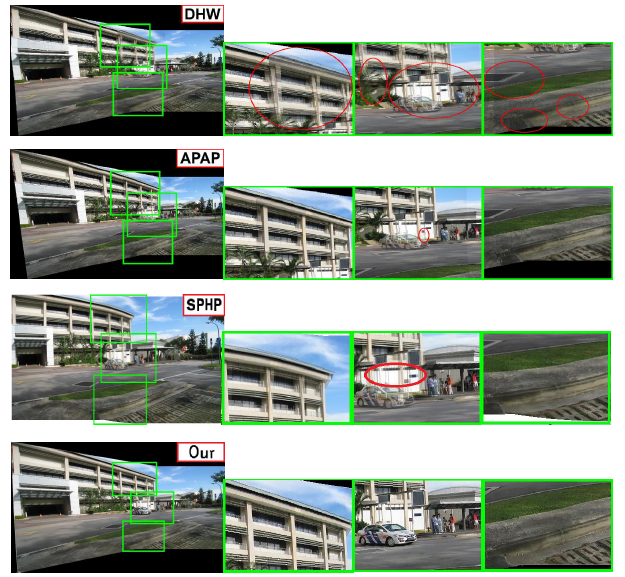
Comparisons among dual homography warp (DHW) [6],